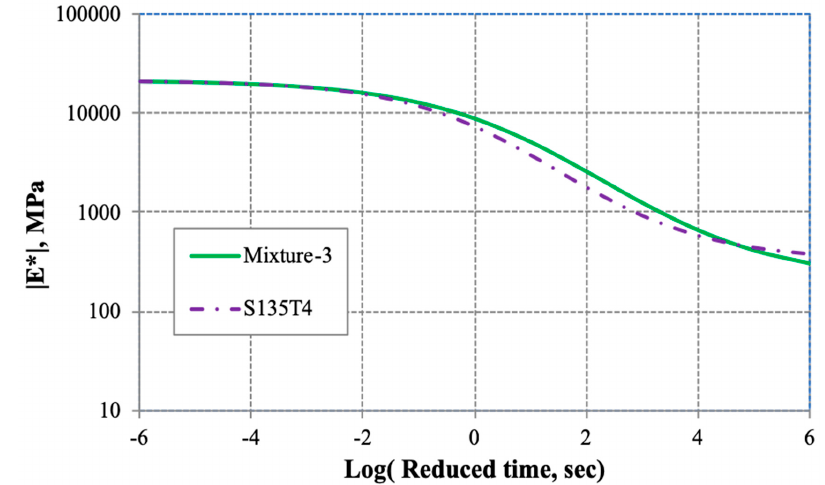
Figure 9. Comparison of master curves for wearing course mixture from the site (mixture 3).